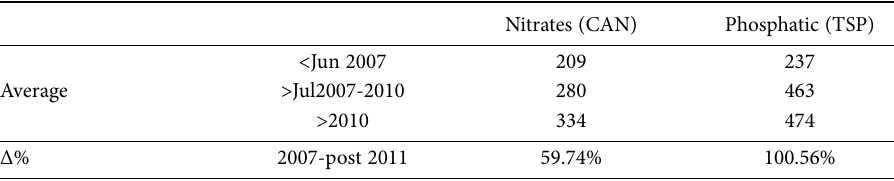
Table 2. Evolution of fertilizer prices in the Emilia-Romagna region.